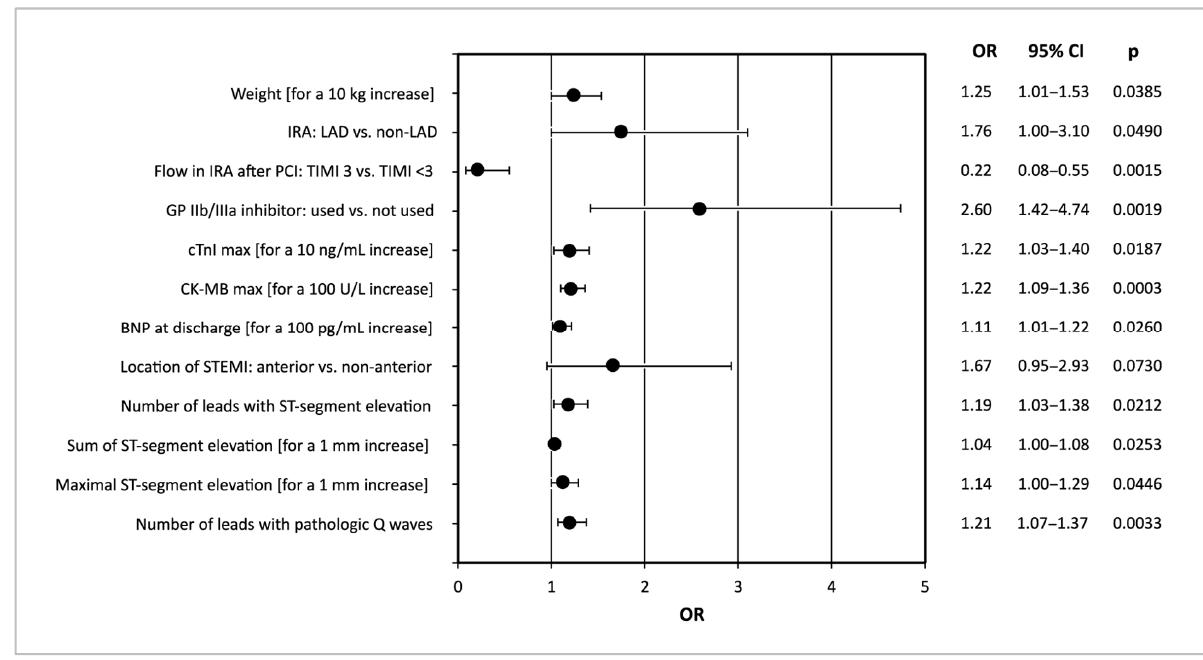
Figure 2. Demographic, clinical, angiographic, biochemical and electrocardiographic predictors of LVR 6 months after STEMI in univariate logistic regression analysis. BNP, B-type natriuretic peptide; CI, confidence interval; CK-MB max , maximal activity of creatinine kinase MB isoenzyme; cTnI max , maximal concentration of cardiac troponin I; IRA, infarct-related artery; LVR, left ventricular remodeling; OR, odds ratio; PCI, percutaneous coronary intervention; STEMI, ST-segment elevation myocardial infarction; TIMI, Thrombolysis in Myocardial Infarction score.